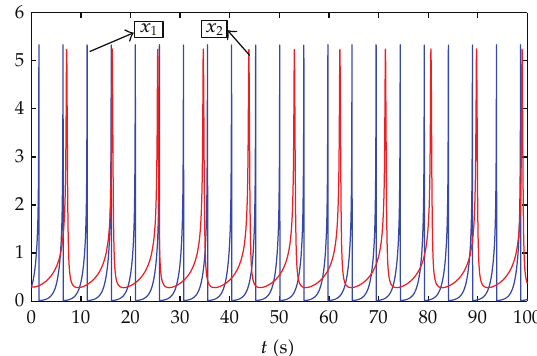
Figure 1: Two-dimension predator system without the